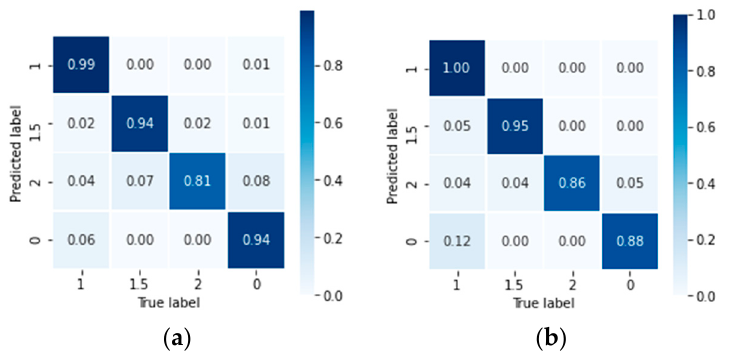
Figure 14. The normalized confusion matrix of test datasets from (a) M1 and (b) M2 based on the BP network. Table 4. The results of defect depth recognition based on datasets M1 and M2. Method